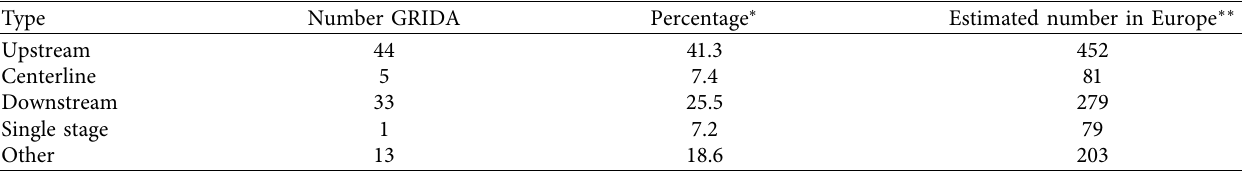
Table 5: Estimation of Europe tailings number by